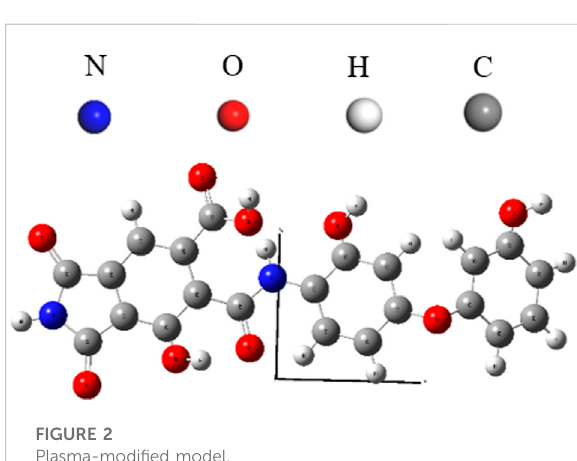
FIGURE 2 Plasma-modi fi ed